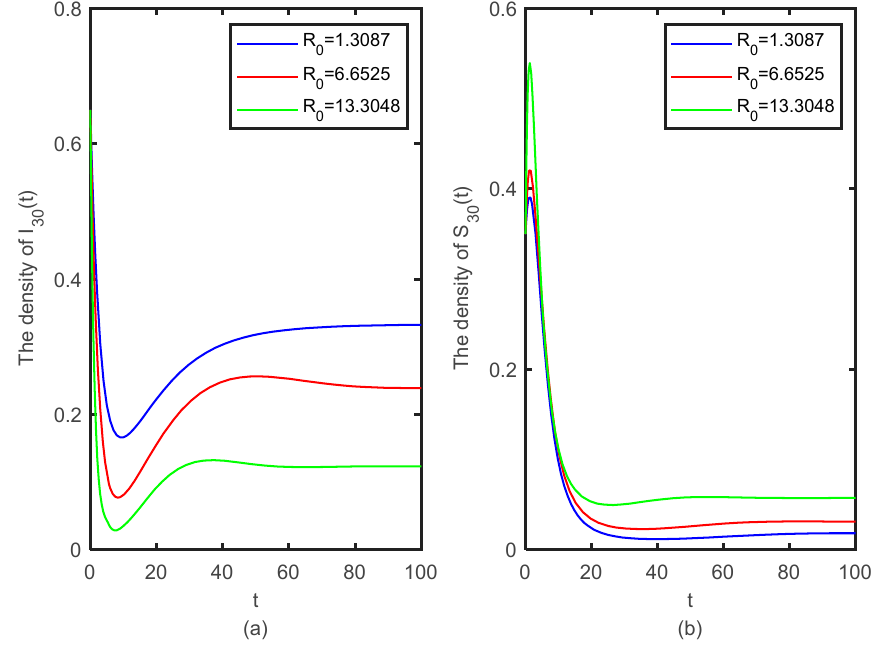
Figure 4. The densities of I 30 ( t ) ( a ), S 30 ( t ) ( b ), considering the variance of R 0 when R 0 >